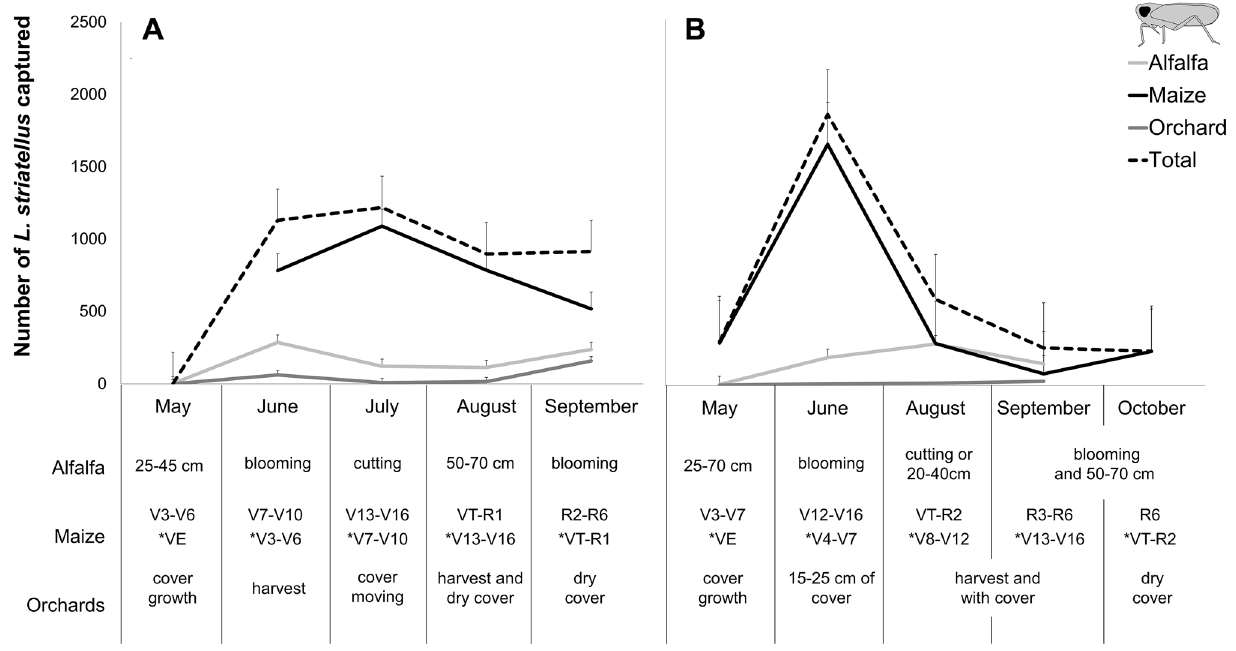
Figure 2. Abundance of L. striatellus during the maize growing season. The table shows differences in the phenology and management of sampled crops.